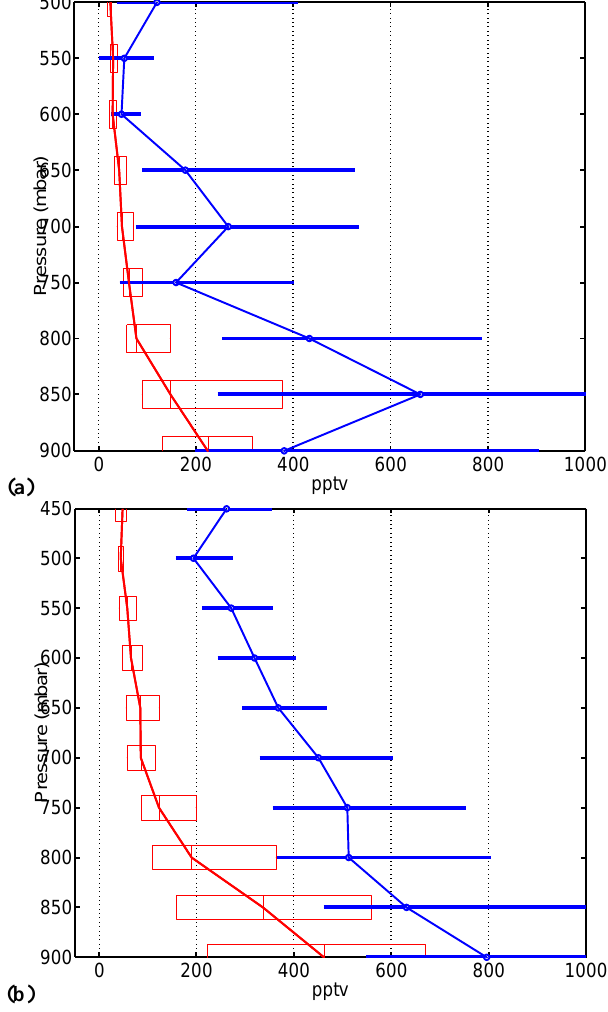
Fig. 10. (a) TexAQS II and (b) ITCT 2k4. Comparison between measured (blue) and modeled (red) vertical AA profiles. The box (thick line) extent represents the 25% and 75%